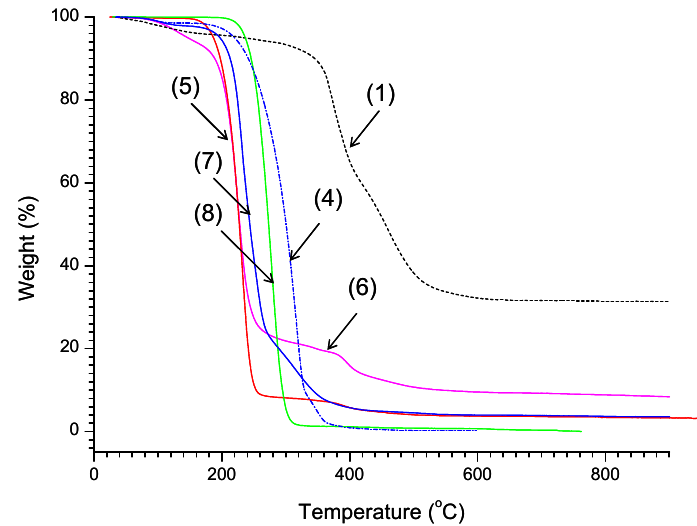
Figure 10. TGA traces of (POSS-S-OH)(1), (iBu-POSS-S-OH)(4) silsesquioxane and (POSS-S-PLA)(5) polylactides star polymer hybrid with an 8 arm length of 23 repeat units ( M n = 28,500), (POSS-S-PLA)(6) polylactides star polymer hybrid with an 7.63 arm length of 7 repeat units ( M n = 9050), (iBu-POSS-S-PLA)(7) linear hybrid ( M n = 3600) and Bu-polylactide polymer ( M n = 17,800, PDI = 1.4)